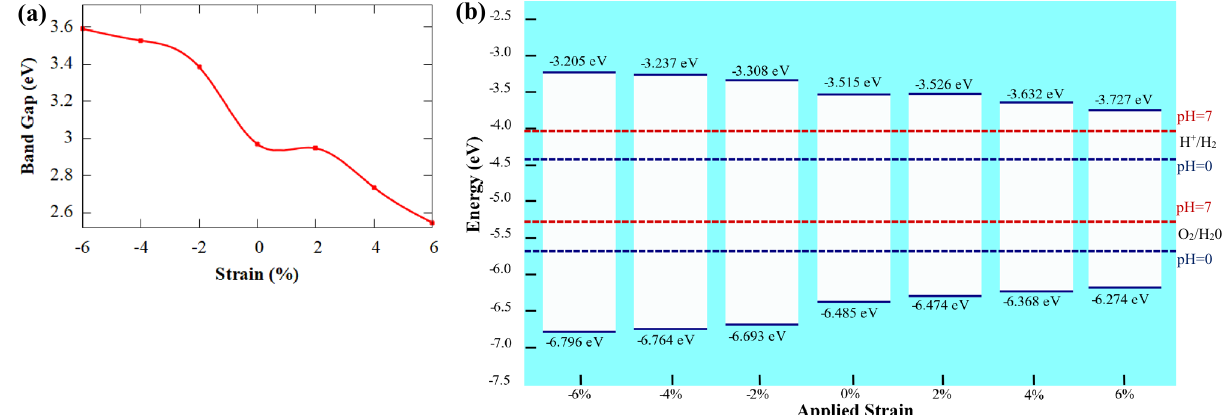
Figure 7. ( a ) Variation of the bandgap energy of the SiC/AlN heterobilayer (AA-2 Configuration) with respect to the external biaxial strain applied to the structure. ( b ) Evolution of the band edge position of the heterostructure for the AA-2 configuration as a function of the varying percentages of the biaxial strain.